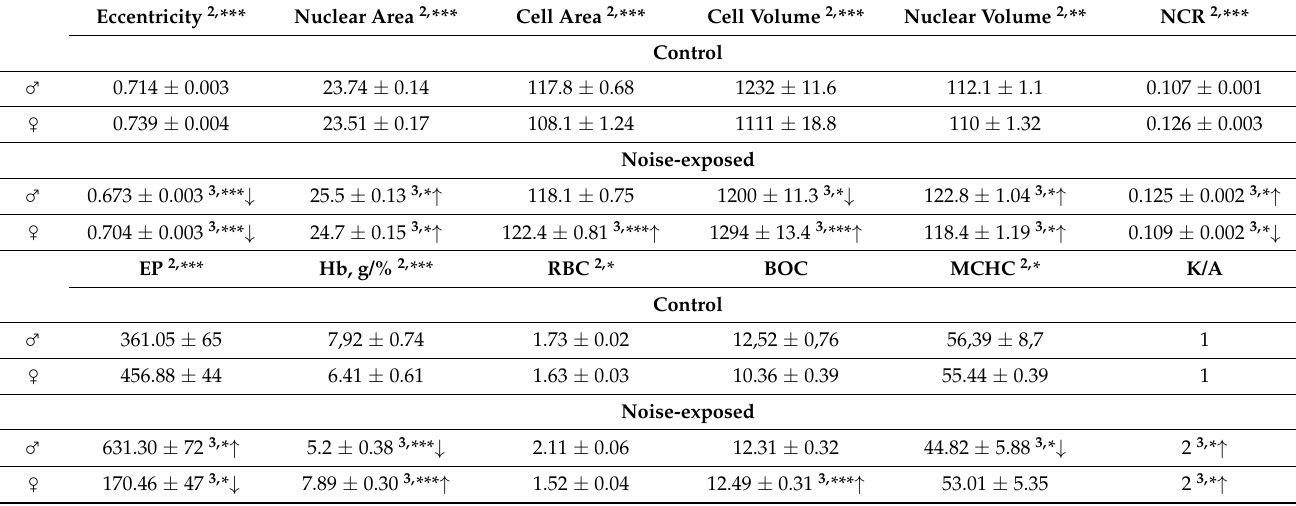
1 NCR, nuclear-cytoplasmic ratio; EP (1 × 10 6 µ m 3 /L mm 3 ), the enriched pool of functionally active mitochondria; Hb (g/L), hemoglobin concentration; RBC, the number of the red blood cells per 1 mL3; BOC (volume units), blood oxygen capacity; MCHC ( µ g/ µ L), hemoglobin content in red blood cells; K/A, hemoglobin cathode-anode fractions ratio. Data are presented as mean ± standard deviation. 2 Statistically significant differences between the sexes in the experimental group are shown immediately next to the name of the studied indicator with asterisks. 3 Statistically significant differences in the experimental groups compared with the control group are indicated with asterisks: * p < 0.05, ** p < 0.01, *** p < 0.001 (Kruskal-Wallis test). Arrows demonstrate a significant decrease ( ↓ ) or an increase ( ↑ ) in parameters compared to the